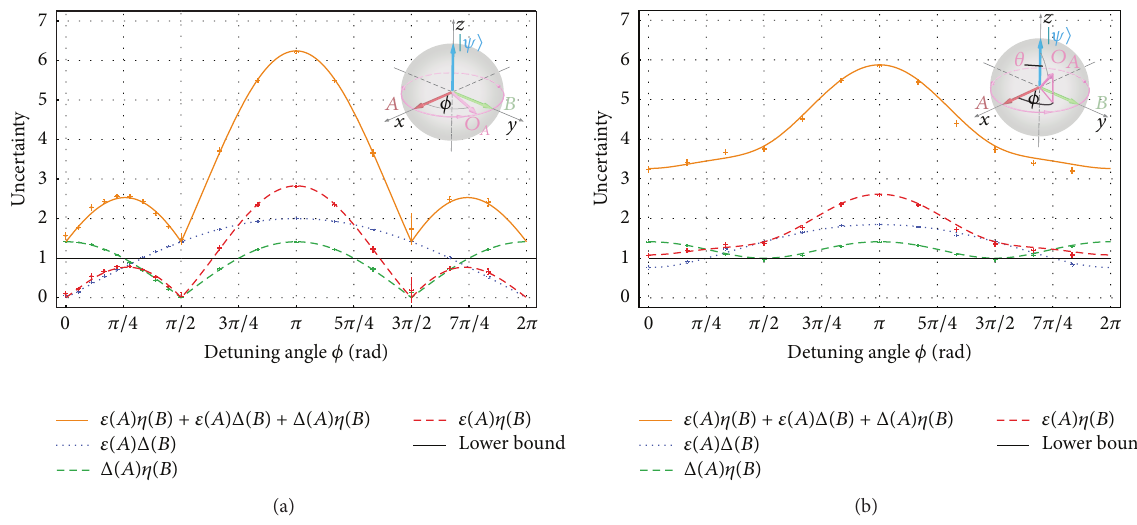
Figure 5: Experimentally determined values of 𝜖(𝐴)Δ(𝐵) , Δ(𝐴)𝜂(𝐵) , and 𝜖(𝐴)𝜂(𝐵) . This last term corresponds to the left-hand side of the Heisenberg relation (4), and the sum of the three terms corresponds to the left-hand side of Ozawa’s relation (5), including Bloch sphere representation of observables and initial state.